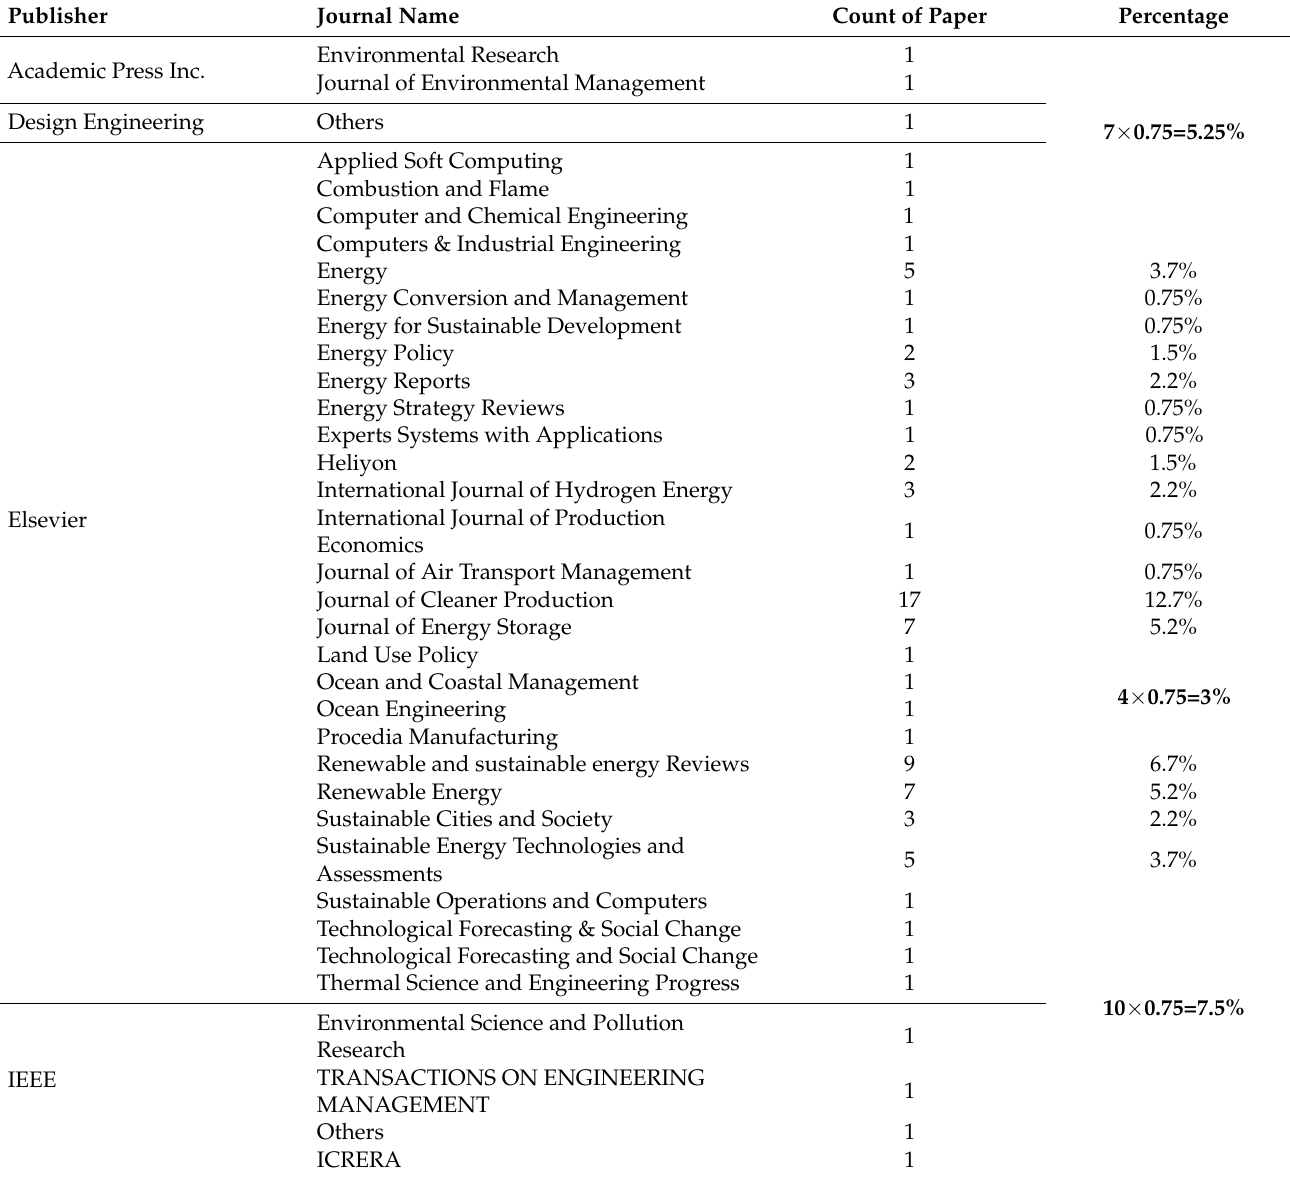
Table 6. Distribution of papers based on journals and